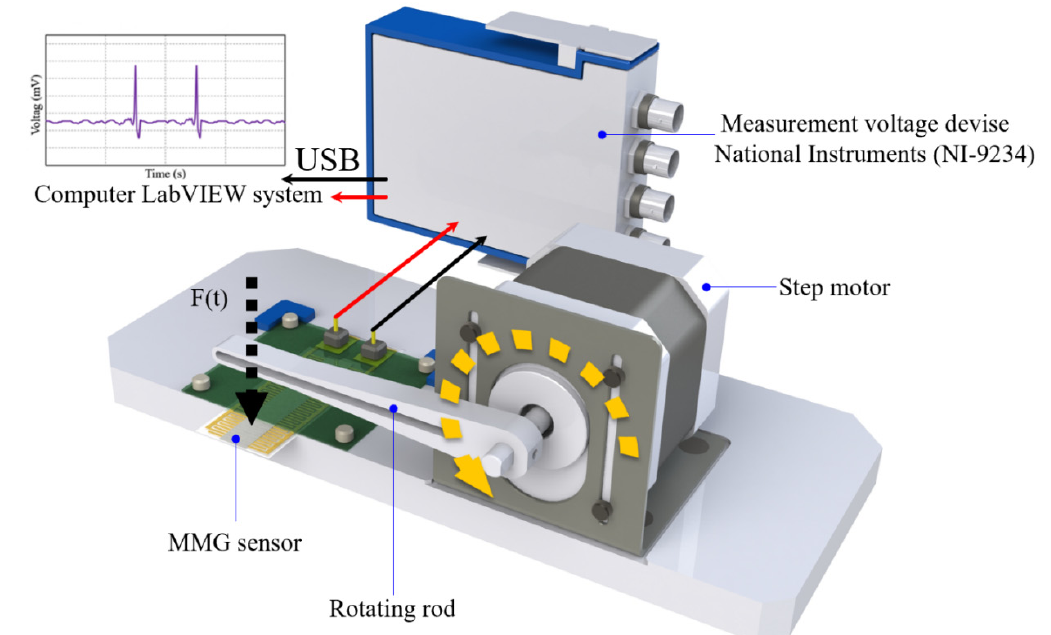
Figure 3. Electrical measuring equipment to capture Polyvinylidene fluoride (PVDF) piezoelectric fibers sensor signals. Table 1. Technical data of silver paste PAX-767-2.